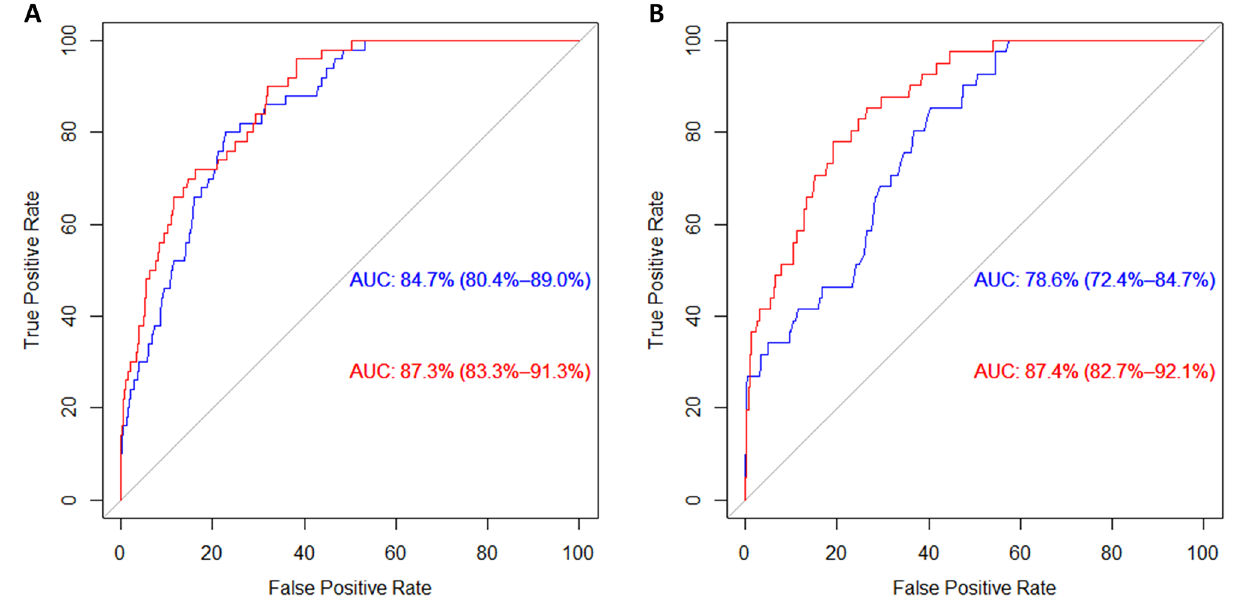
Figure 3. Receiving operating curves for the risk of cardiovascular events in ( A ) the whole population of patients and controls and ( B ) nephrosclerosis patients. The blue line corresponds to the model with classic risk factors and the red line corresponds to the same model when genetic information is added. AUC area under the